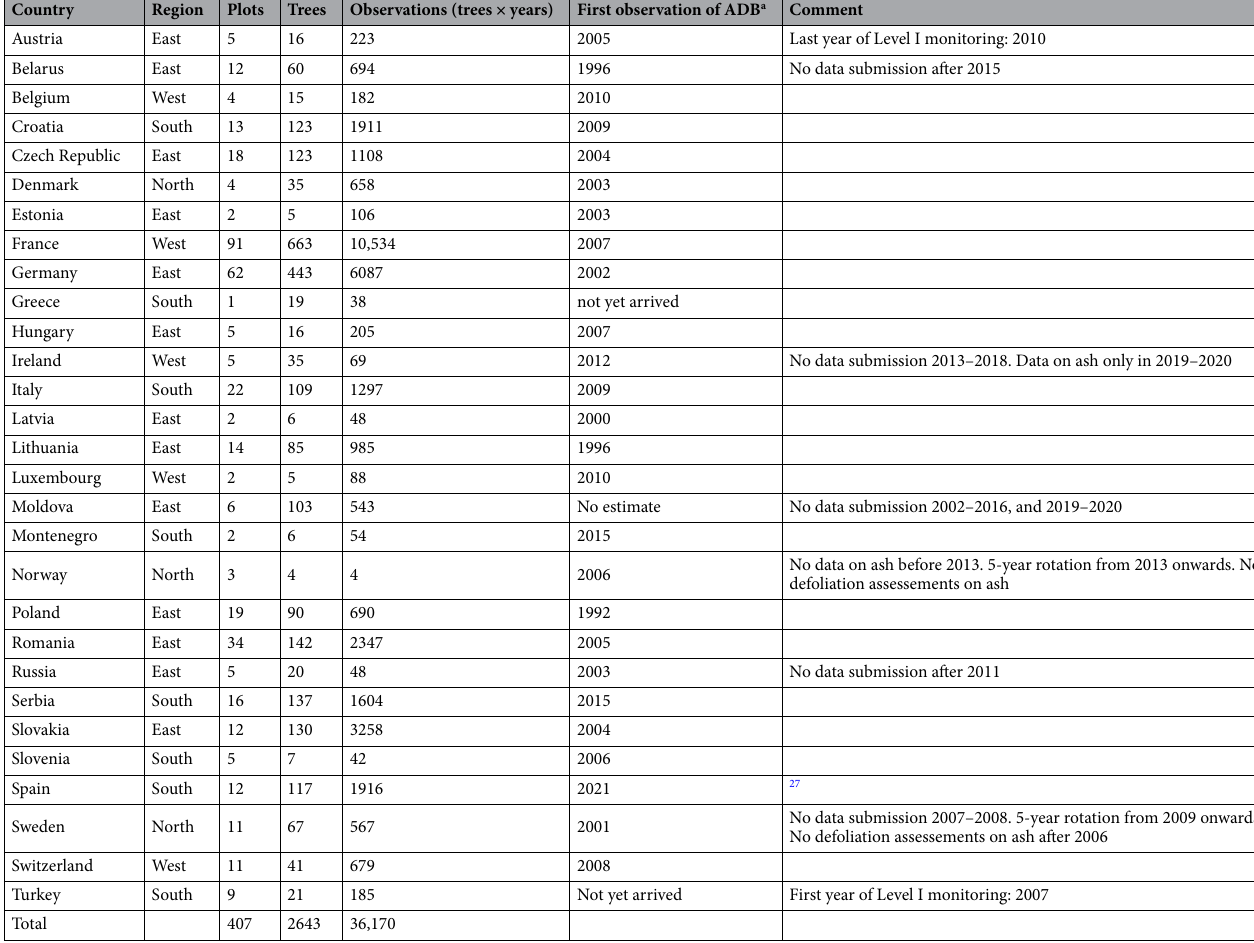
Table 1. Summary of observations by country. a The dates of first arrival of ADB were compiled from national reports inVasaitis and Enderle 6